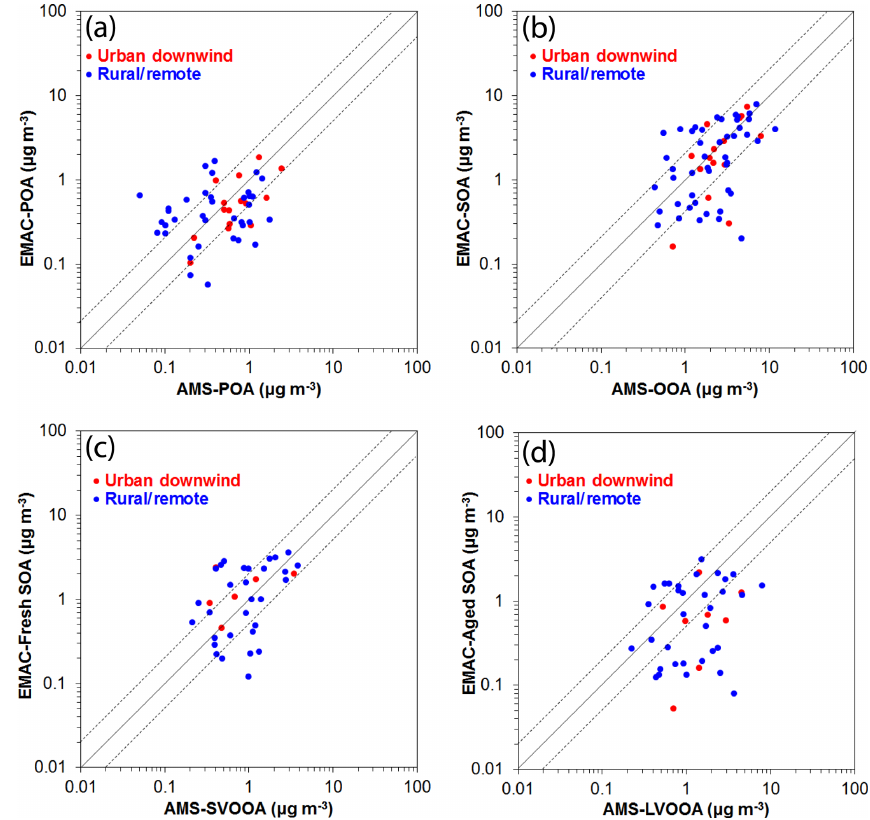
Figure 8. Scatterplots comparing model predictions to AMS measurements and their PMF analysis for (a) POA, (b) OOA, (c) SVOOA, and (d) LVOOA concentrations (in µgm − 3 ) in the Northern Hemisphere during 2001–2010. Each point represents the dataset average value over urban downwind (in red) and rural–remote (in blue) sites. Also shown are the 1 : 1, 2 : 1, and 1 : 2 lines.